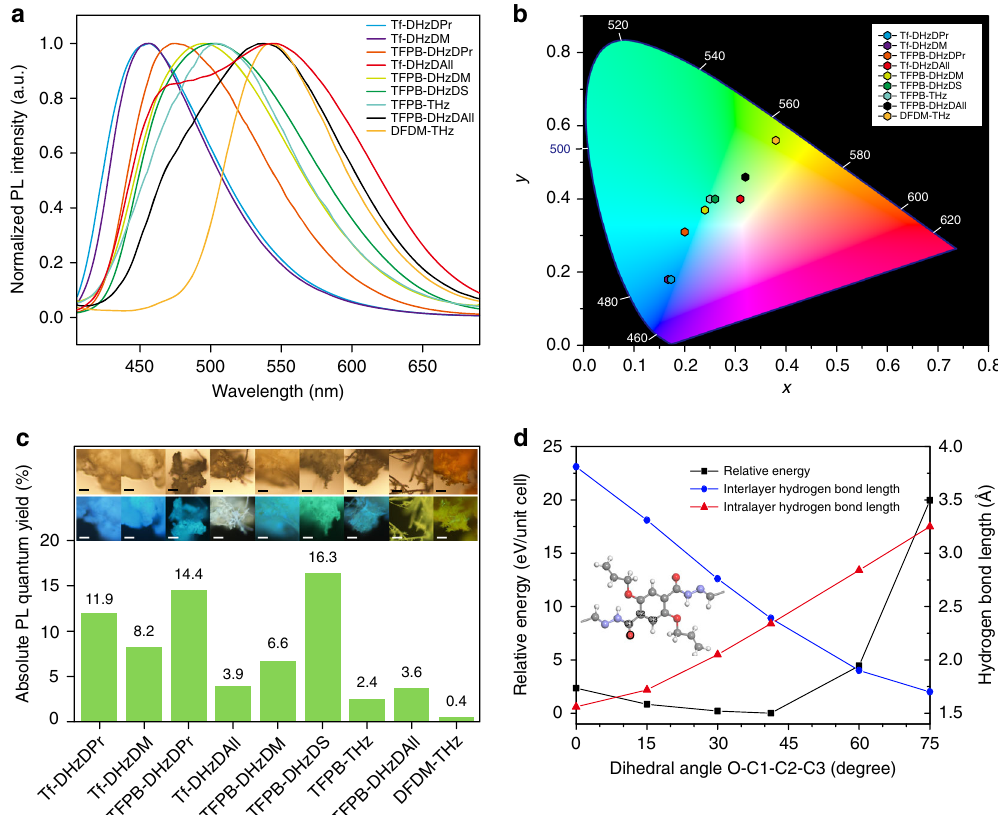
Fig. 4 Solid-state photoluminescent properties of the tuneable emissive COFs. a Solid-state PL spectra. b CIE-1931 chromaticity diagram of various COFs. All measurements were performed on solid samples under an excitation wavelength of 365 nm. c Absolute PL quantum yields of each COF; inset: fl uorescence microscopic images of COFs under visible light (upper) and UV irradiation (down) (scale bar, 50 µ m). d Torsional potential energy scan of Tf-DHzDAll COF at different dihedral angles; inset: molecular fragment of Tf-DHzDAll COF to show the dihedral angle O-C1-C2-C3 (C, grey; N, violet; O, red; H,